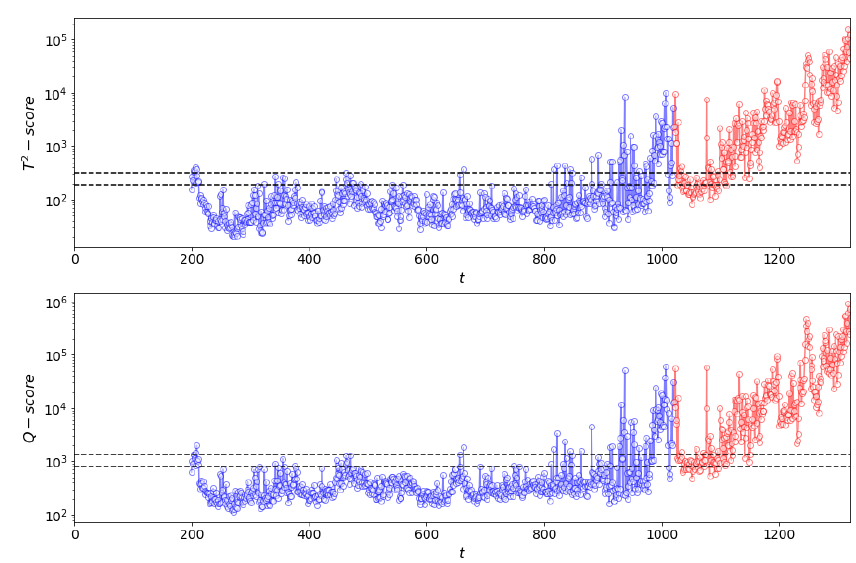
Figure 25. T 2 ( top ) and Q ( bottom ) process monitoring charts of multivariate grinding circuit data for a window length of 200 time steps using Method I. NOC (trained) data are shown in blue and test (fault) data in red.